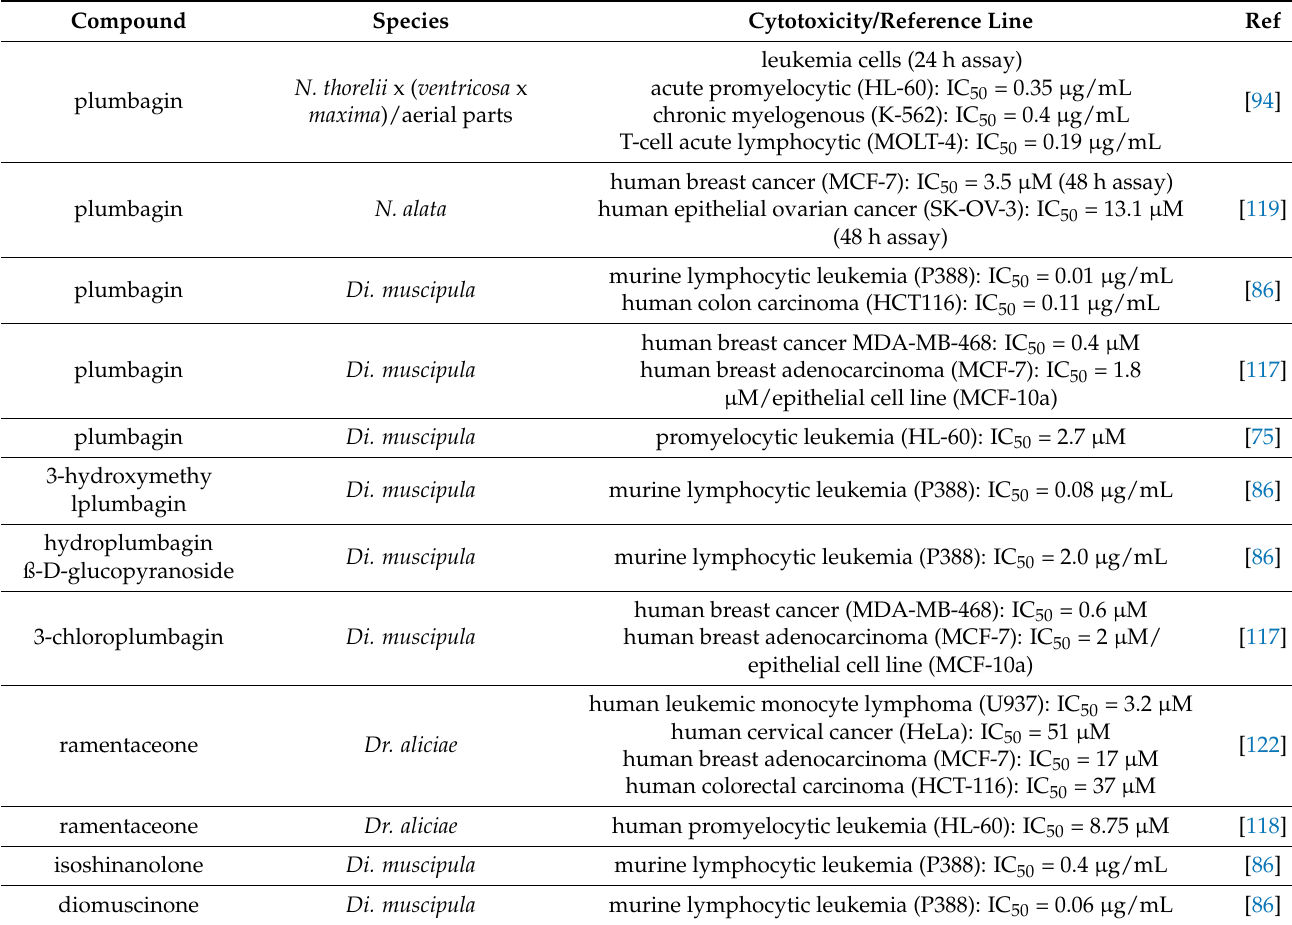
Table 4. Cytotoxic activity of naphthoquinones isolated from Droseraceae and Nepenthaceae.